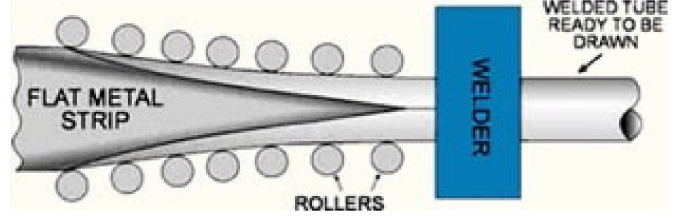
Figure 1. The manufacturing process of a welded hypotube.